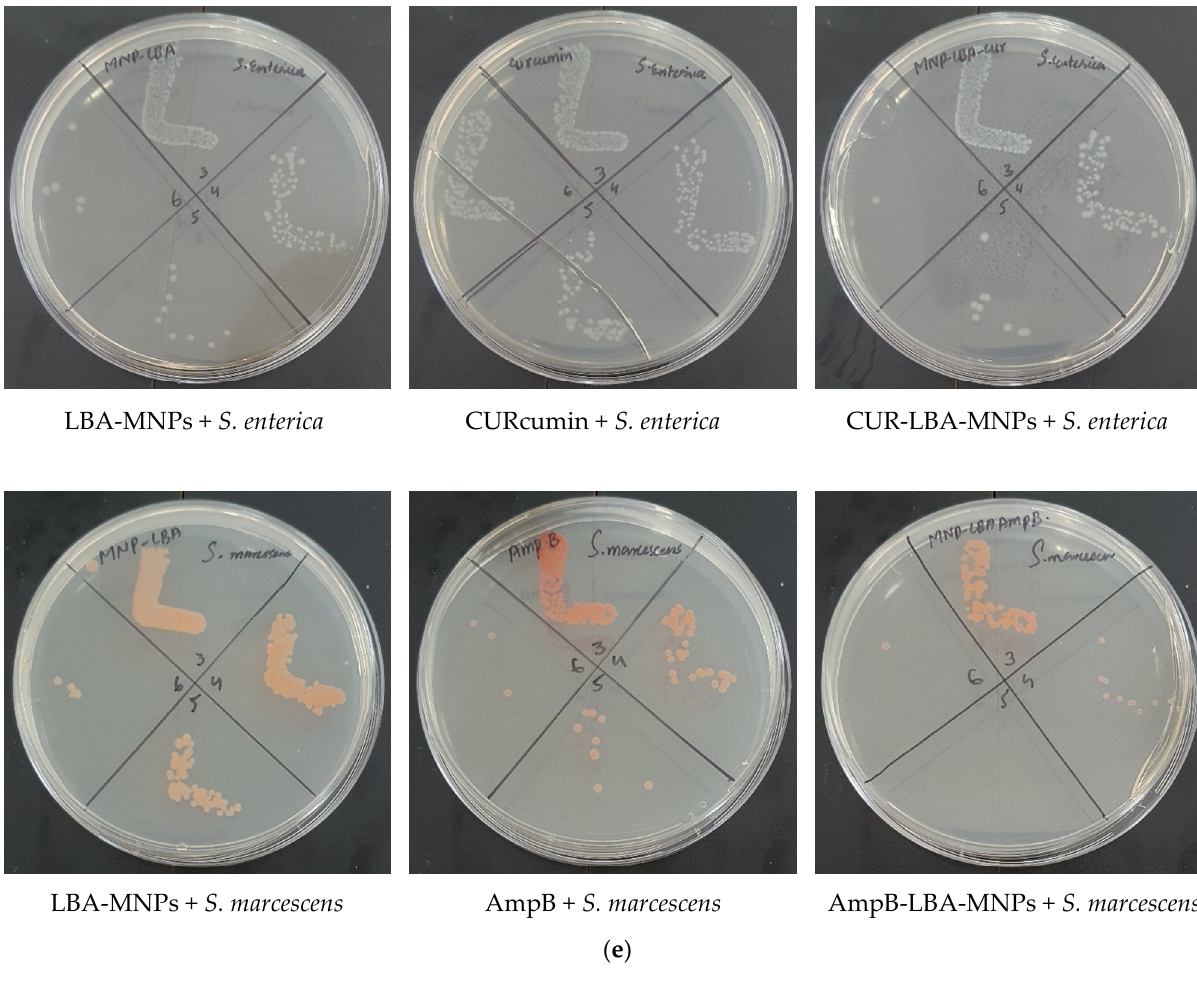
Figure 5. Drugs and drug-based magnetic NPs presented important antibacterial activity against Gram-positive pathogenic bacteria. Briefly, NPs and drug conjugates were incubated with one million bacteria at 37 °C for 2 h. After this, cultures were serially diluted (ten-fold) and plated on nutrient agar plates. The plates were incubated overnight at 37 °C, and subsequently, viable bacteria were counted. For controls, bacteria incubated alone in PBS and with gentamicin (100 µg/mL) were used as negative and positive controls, respectively. ( a ) Antibacterial effects against S. marcescens ; ( b ) bactericidal activity against S. enterica ; ( c ) against P. aeruginosa ; ( d ) against E. coli K1; ( e ) illustrative antibacterial effects against S. enterica and S. marcescens . The data are expressed as the means ± standard error of several independent experiments performed in duplicate where (*) and (**) represents when p ≤ 0.05 and p ≤ 0.01 respectively.